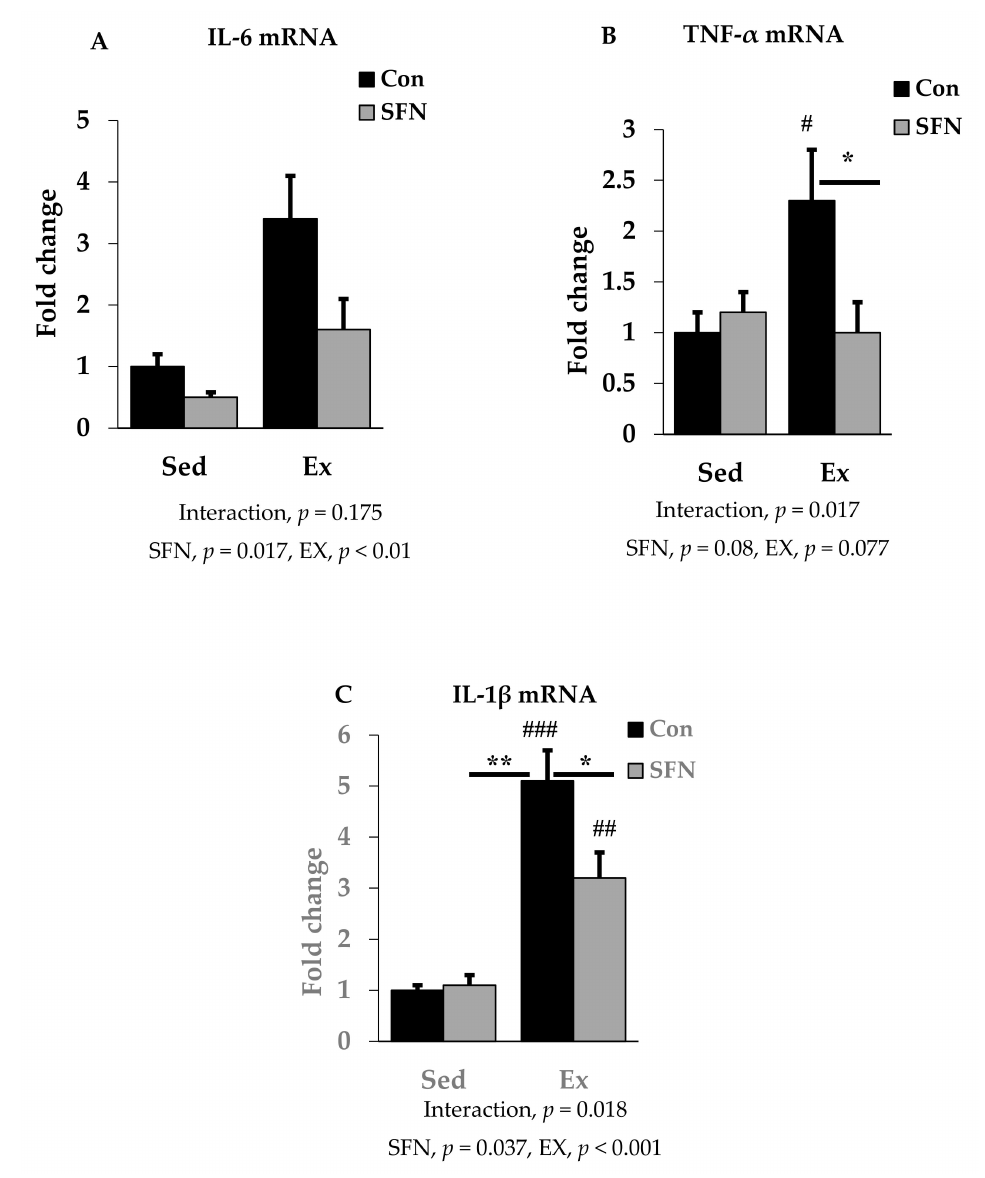
Figure 3. Interleukin-6 (IL-6) mRNA ( A ), Tumor necrosis factor- α (TNF- α ) mRNA ( B ), and Interleukin-1 β (IL-1 β ) mRNA ( C ) expression in the comparison between the sedentary (Sed) and exercise (Ex) groups, with (sulforaphane; SFN) or without (control; Con) supplement. ### p < 0.001, ## p < 0.01, # p < 0.05 as compared to the sedentary control. ** p < 0.01, * p < 0.05. Interaction of SFN and Ex written as “Interaction”. Data are presented as mean ±